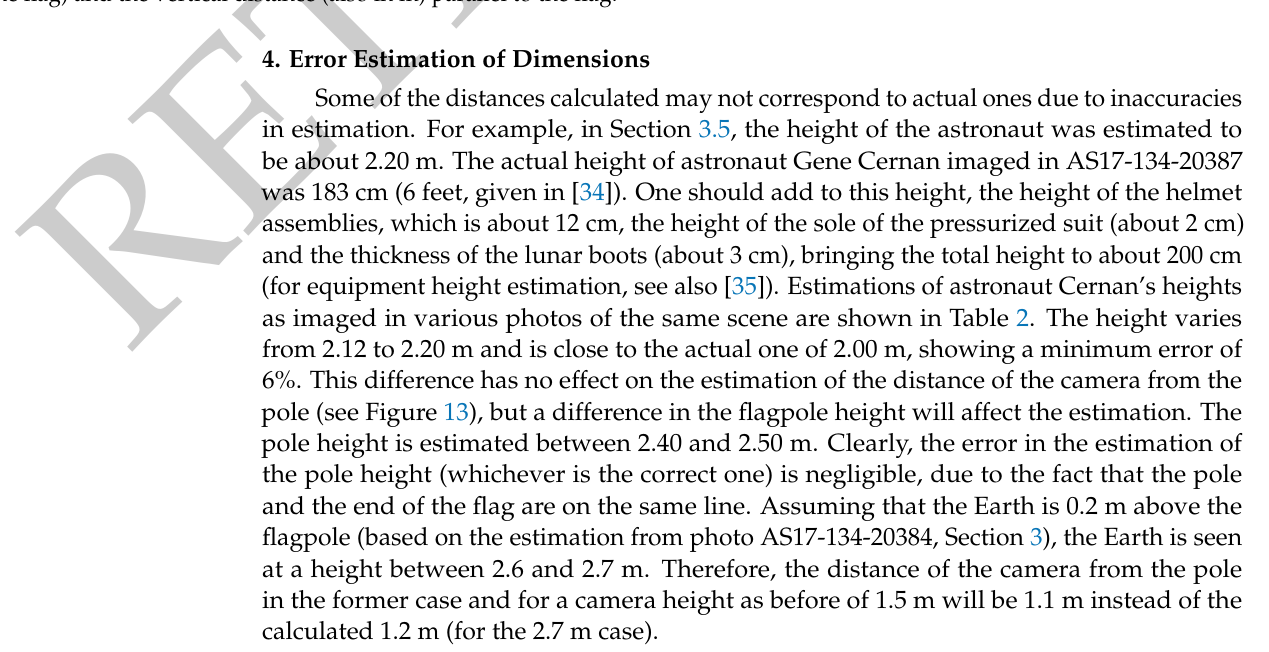
Figure 25. Simulation results showing the astronaut’s position taking the photo estimated, first by the position of the Earth in the photo (1.2 m), blue mark; second by the position of the astronaut’s shadow on the screen reflection of the helmet (3.5 m from the flag end), red mark. A, B, C and D indicate the positions from which the images presented in Figures 21 and 23 were captured. Numbers in parenthesis next to each letter indicate the horizontal distance in m from the flag end (left site of the flag) and the vertical distance (also in m) parallel to the flag.